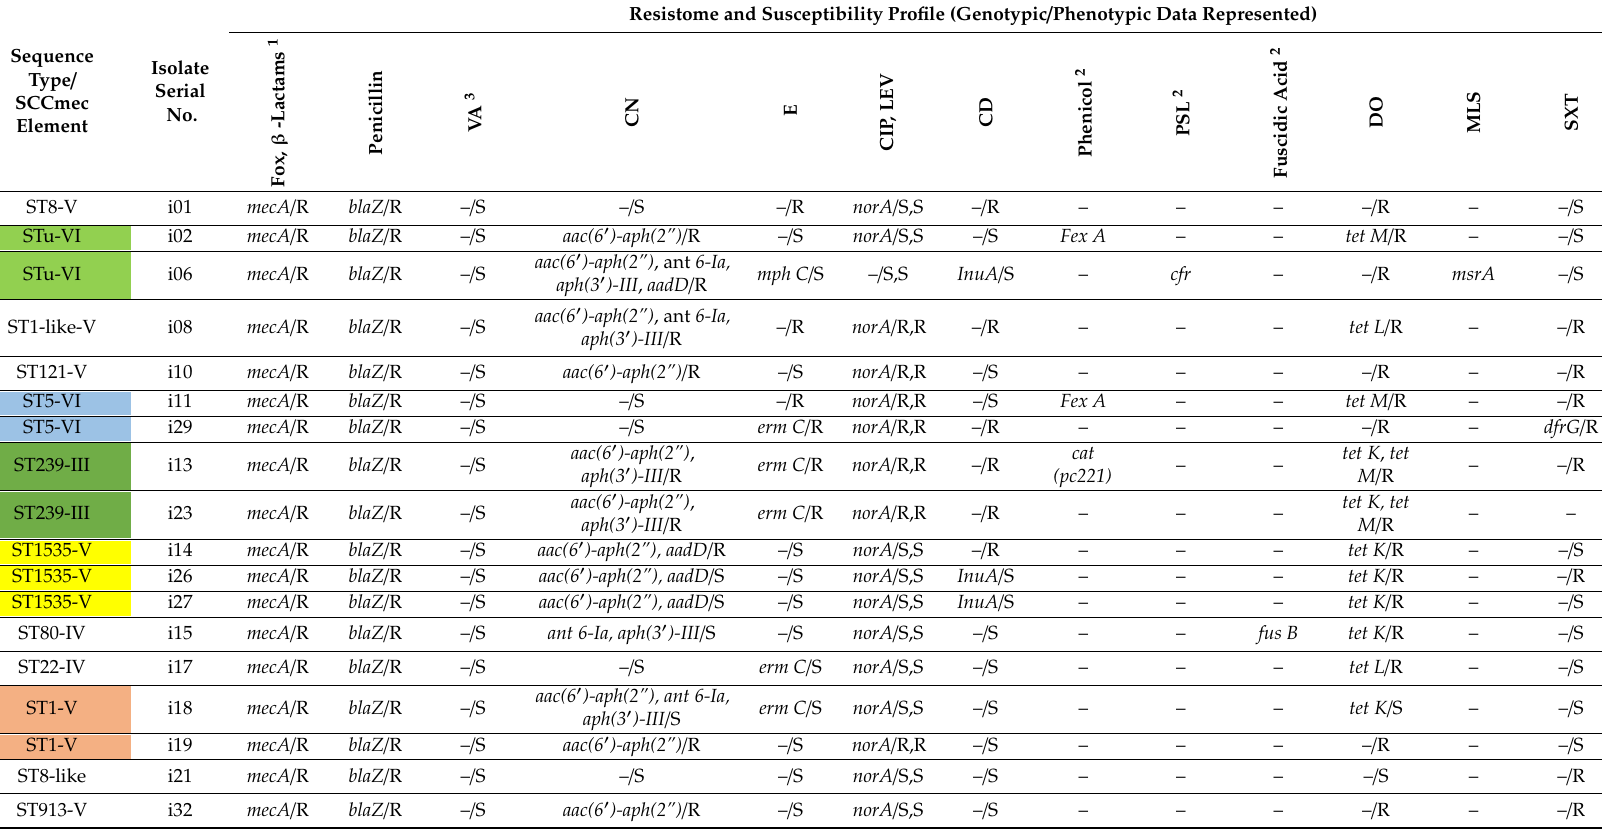
Table 4. Resistance genotypes and phenotypes identified in the MRSA